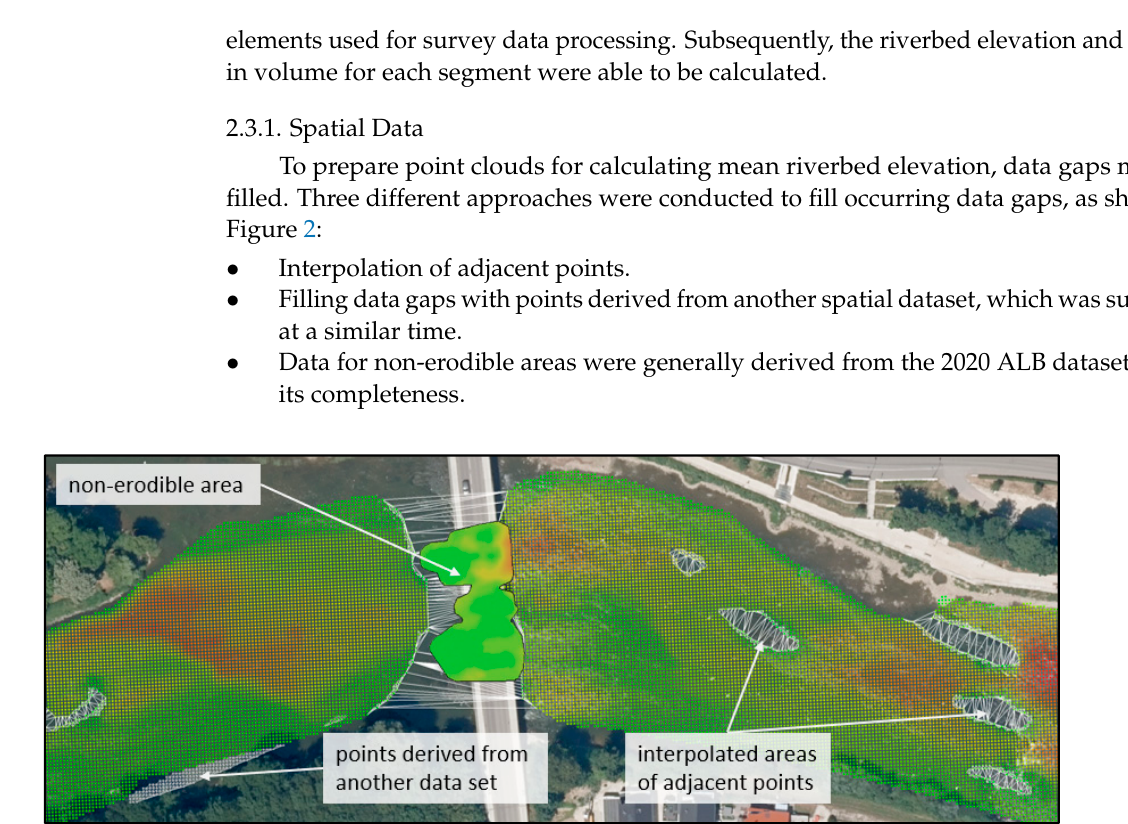
Figure 2. Filling methodology example of a DTM at Augsburger bridge for the 2013-2 dataset with a spatial resolution of 1 m.